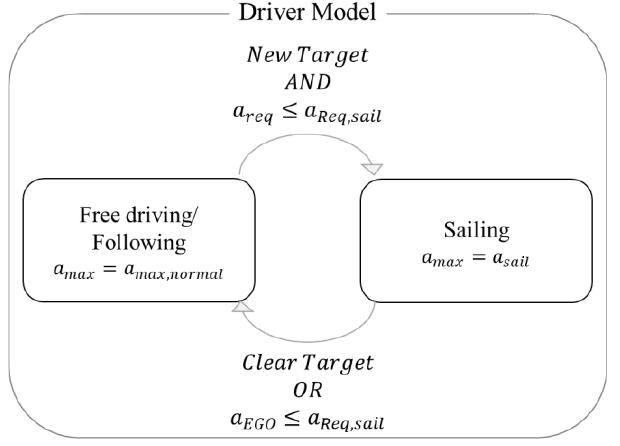
Figure 9. Scheme of the driver model for the proposed longitudinal motion scenario design.